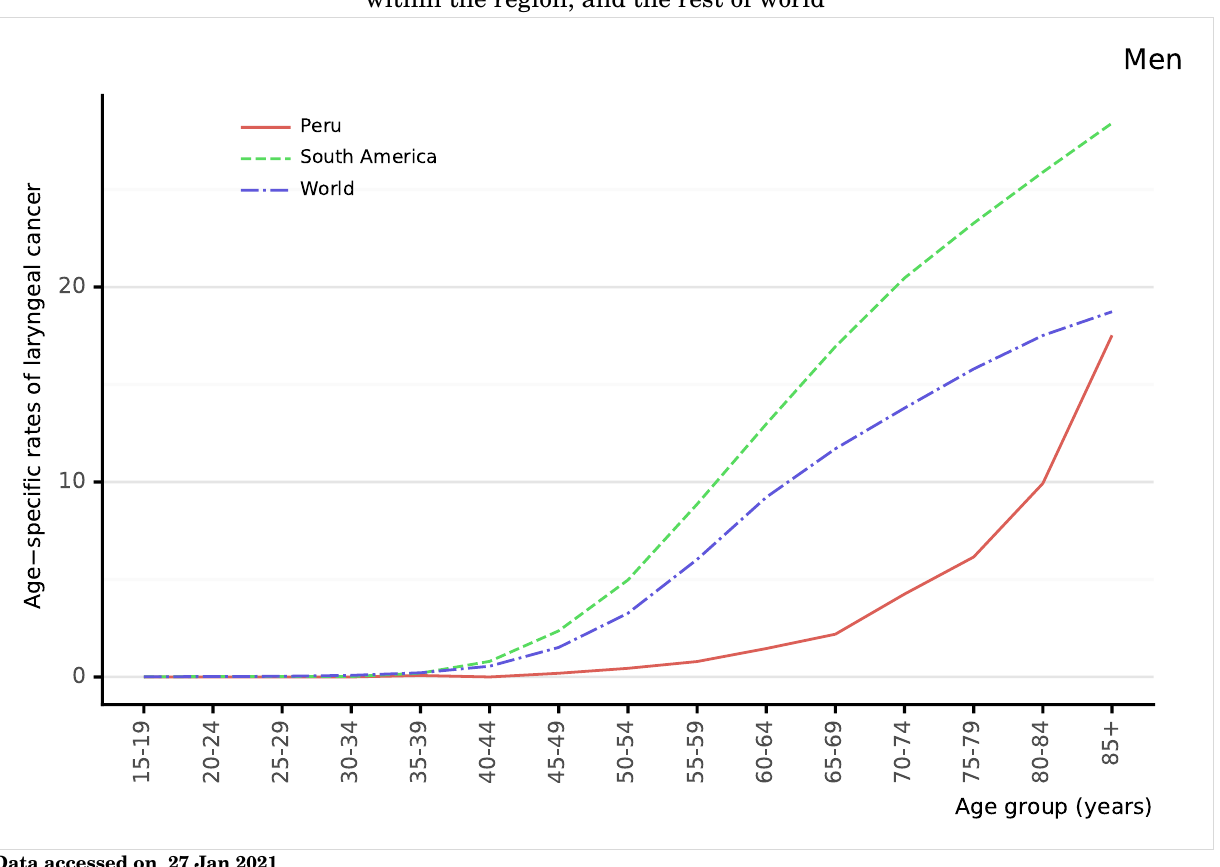
Figure 135: Comparison of age-specific laryngeal cancer mortality rates among men by age in Peru, within the region, and the rest of